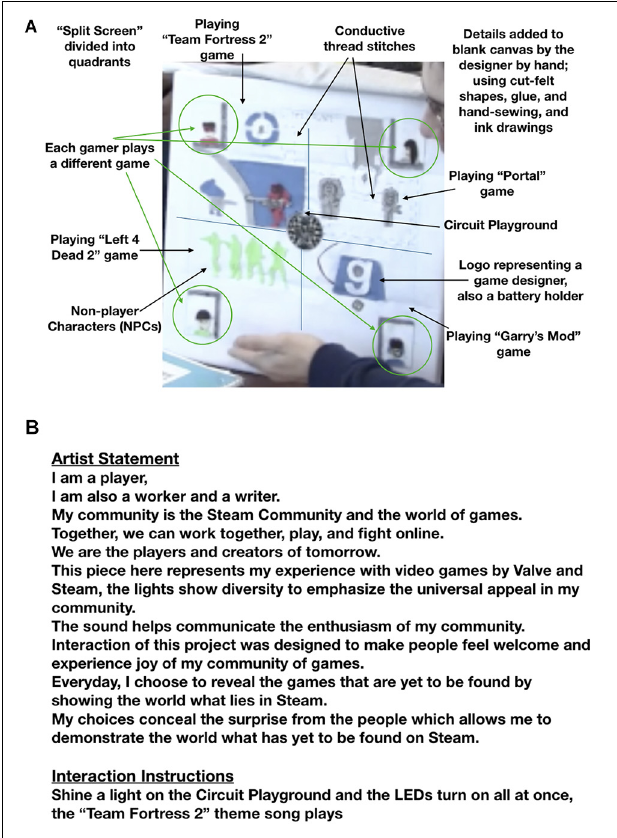
FIGURE 1 | Ramon’s Conceal/Reveal Project, Artist Statement, and Interaction Instructions.